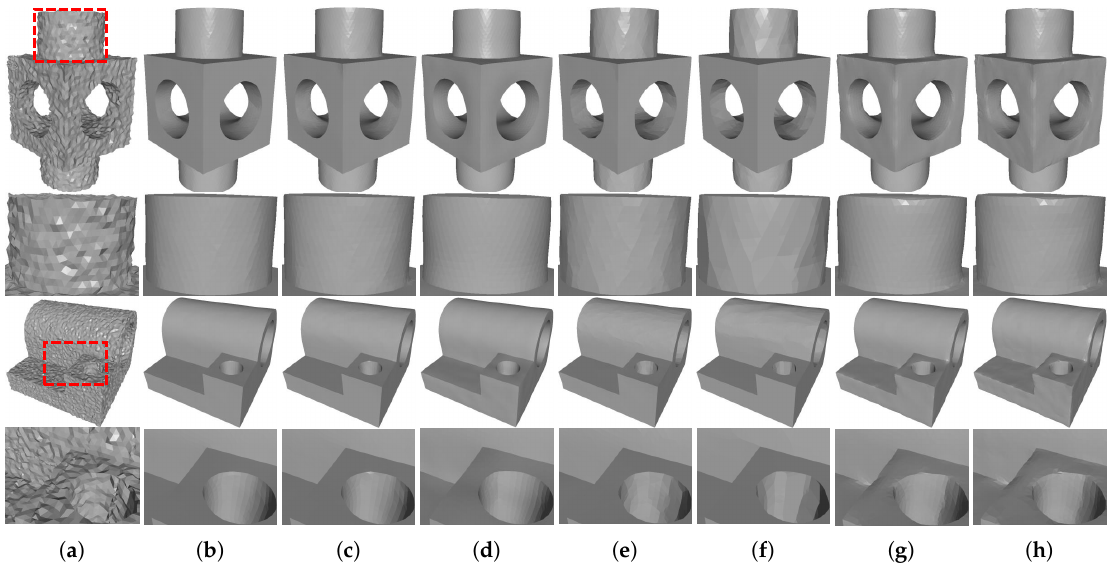
Figure 5. Denoising results of Block and Joint (corrupted by Gaussian noise, standard deviation = 0.2 mean edge length). From left to right: ( a ) noisy meshes, denoising results produced by ( b ) our method TS; ( c ) HO [1]; ( d ) RHM [14]; ( e ) TV [21]; ( f ) (cid:96) 0 [20]; ( g ) localBF [12]; and ( h ) globalBF [12], respectively. The second and fourth rows are zoomed-in